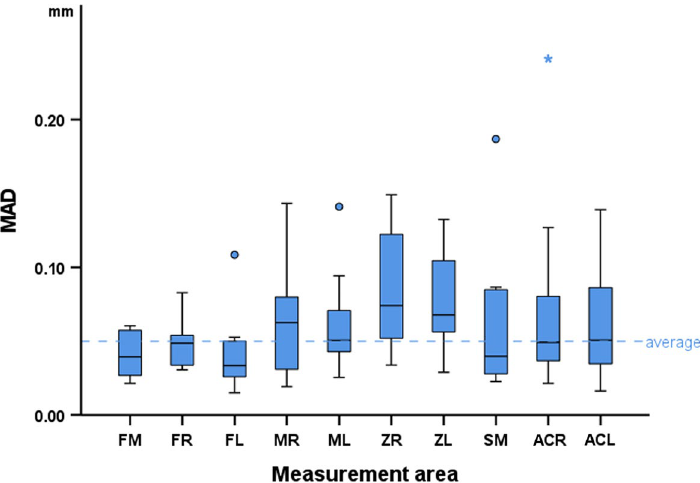
Figure 6. Box plots showing the MAD between dry skull models embedded in water for 5 and 15 min, at each measurement area. MAD: mean absolute distance. Skull: forehead left (FL), right (FR), and middle (FM), maxilla left (ML) and right (MR), zygomatic bone left (ZL) and right (ZR), anterior cranial base left (ACL) and right (ACR) and sphenoid bone middle (SM). Mandible: buccal left (BL), right (BR), and center (BC) and lingual left (LL), right (LR) and center (LC). Outliers are shown as blue dots (further from the median more than 1.5 times the IQR) or stars in more extreme cases (further from the median more than 3 times the IQR).